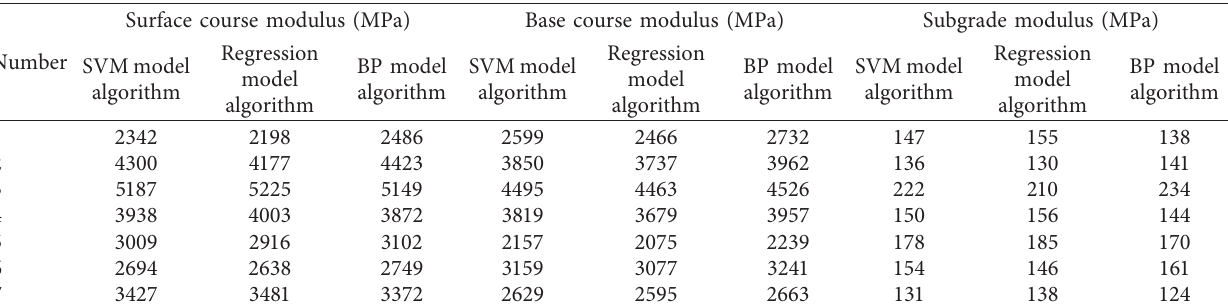
Table 5: Comparison of inversion results of different inversion